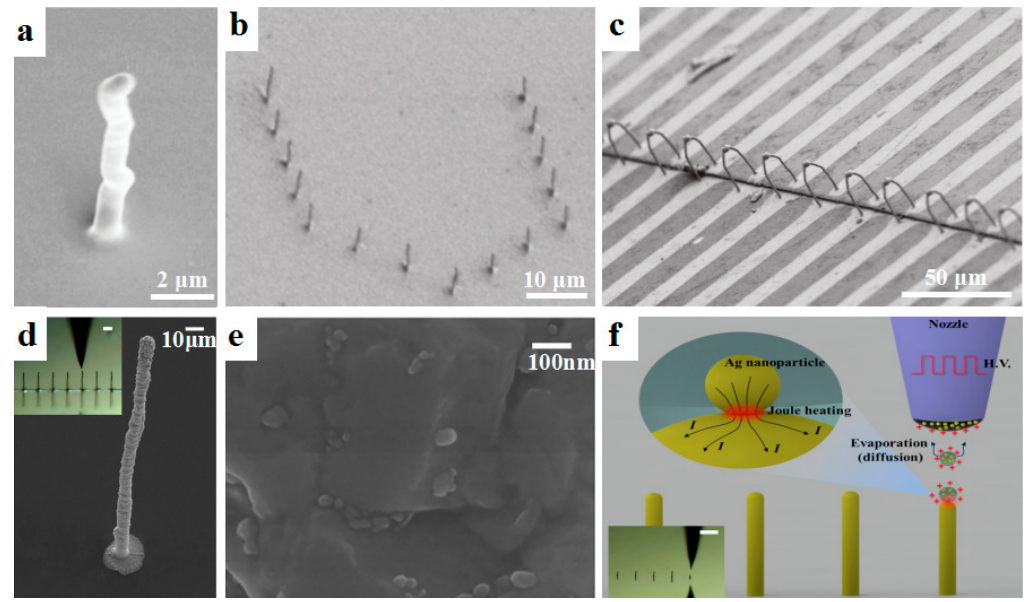
Figure 2. Metal nanoparticles for the micro-/nano-scale 3D printing of conductive features. ( a ) Ag pillar printed by electrohydrodynamic 3D printing; ( b ) A “U-shaped” array of Cu; ( c ) “Bridge-like” Ag interconnects used as electrical connection of the two electrodes, reprinted from [19] with the permission of John Wiley and Sons, Copyright 2015; ( d ) SEM image of an electrohydrodynamically (EHD) printed sub-10 μ m 3D pillar with high aspect ratio over 35. The inset is a photograph of the EHD printing process, and the scale bar is 30 μ m; ( e ) The magnified surface morphology of the Ag nanoparticles on the 3D pillar structure; ( f ) Schematic of spontaneous nanoscale Joule heating in the fabrication of the high-aspect-ratio 3D structures for which the electrohydrodynamic 3D printing technique was employed, reprinted from [30] with the permission of John Wiley and Sons, Copyright 2017.